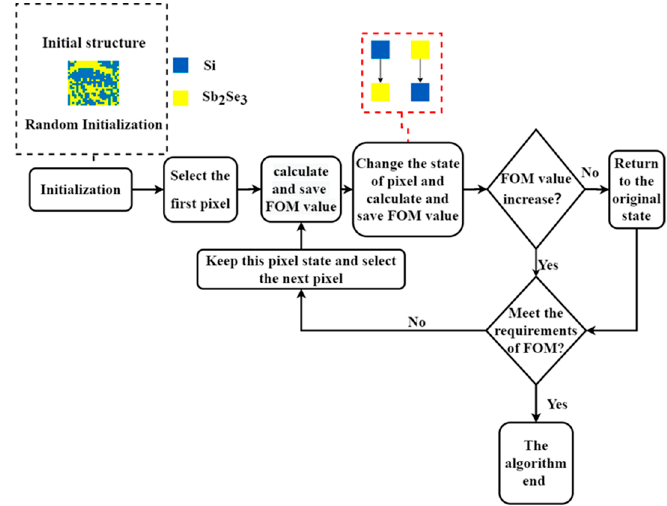
Figure 2. DBS algorithm fl owchart.